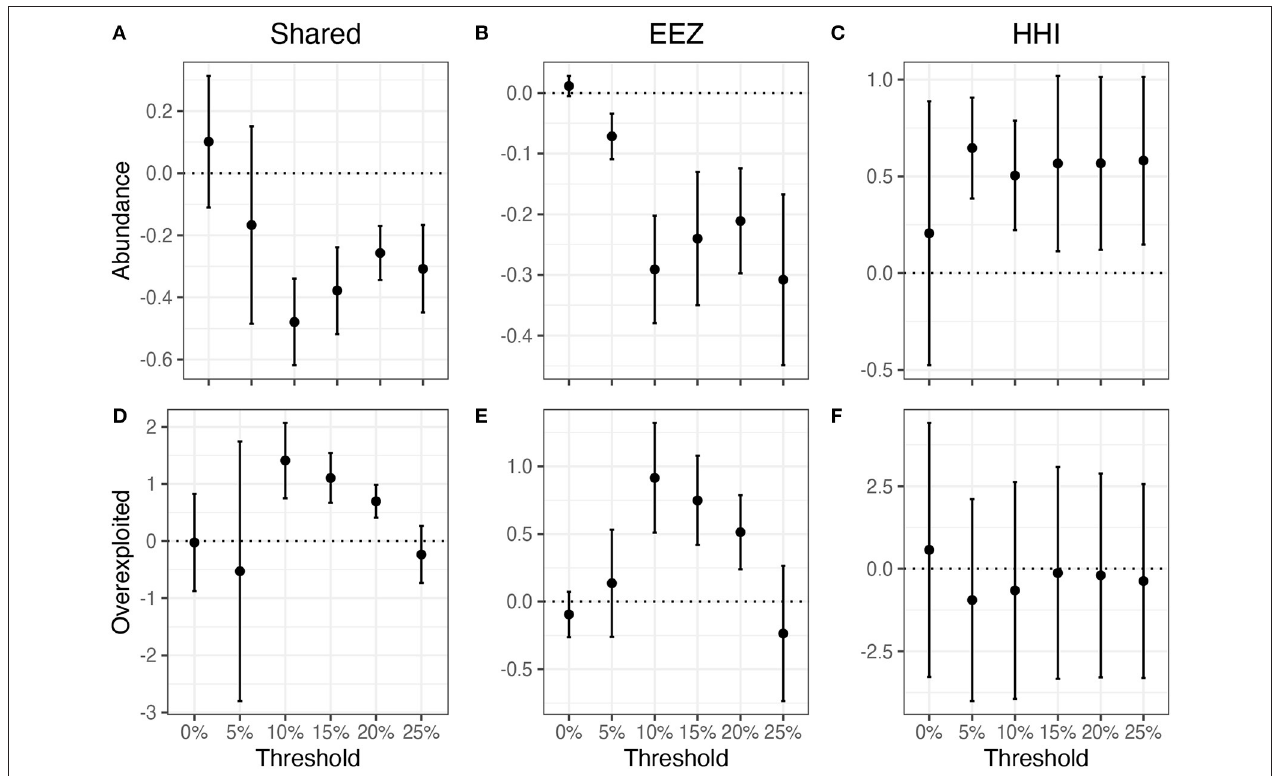
FIGURE 2 | Estimates of the transboundary problem in marine fisheries. All plots show the estimates as a function of the minimum threshold percentage of a stock’s spatial distribution that must be present in each containing EEZ. The top row (A–C) shows the linear regression estimates on abundance, measured as B/B MSY , while the bottom row shows the standard deviation change in the predicted probit index on the odds of a stock being overexploited, measured as B/B MSY < 1 . Columns show effects of a stock being contained in at least 2 EEZs (A,D) , the effect of each additional EEZ (B,E) , and the effect of the stock’s relative spatial concentration across EEZs (C,F) . Note varying y-axis